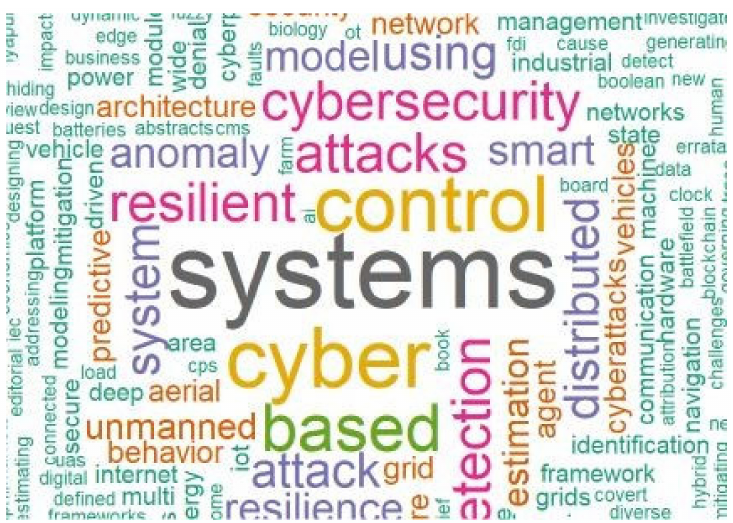
Figure 4. Results of a word cloud of 748 papers.